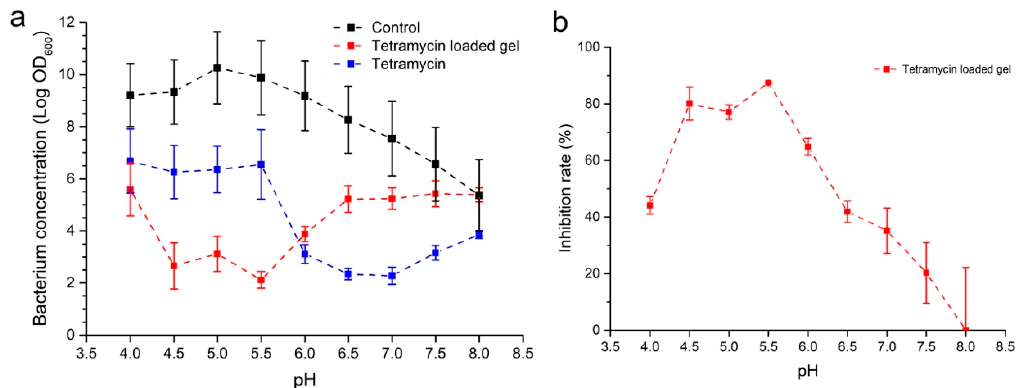
Figure 5. Inhibition activity of tetramycin and tetramycin-loaded ADH-OSA gel to Ralstonia solanacearum . ( a ) Effect on colony density of R. solanacearum after treating by tetramycin and tetramycin gel at different pH conditions. ( b ) The inhibition rate change of tetramycin-loaded gel under different pH conditions.